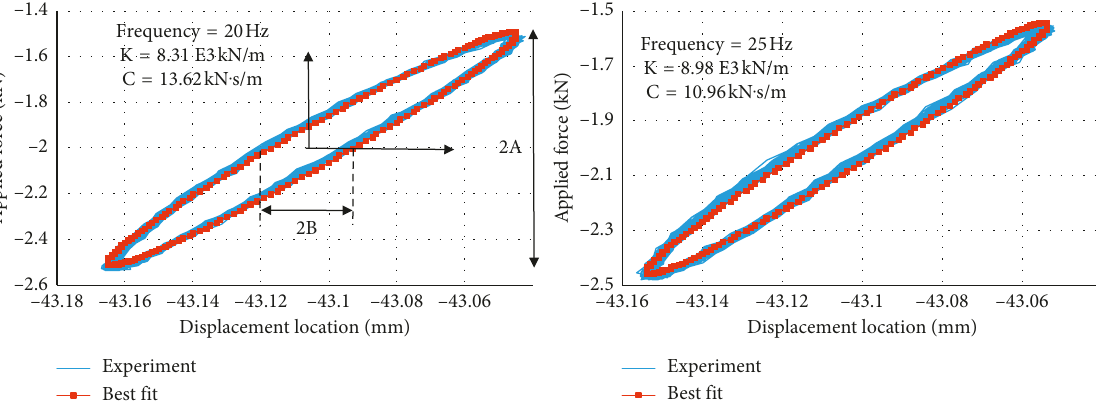
Figure 3: Experimental and best-fit (equations (2) to (5)) results for the rubber pad at 20 and 25Hz.